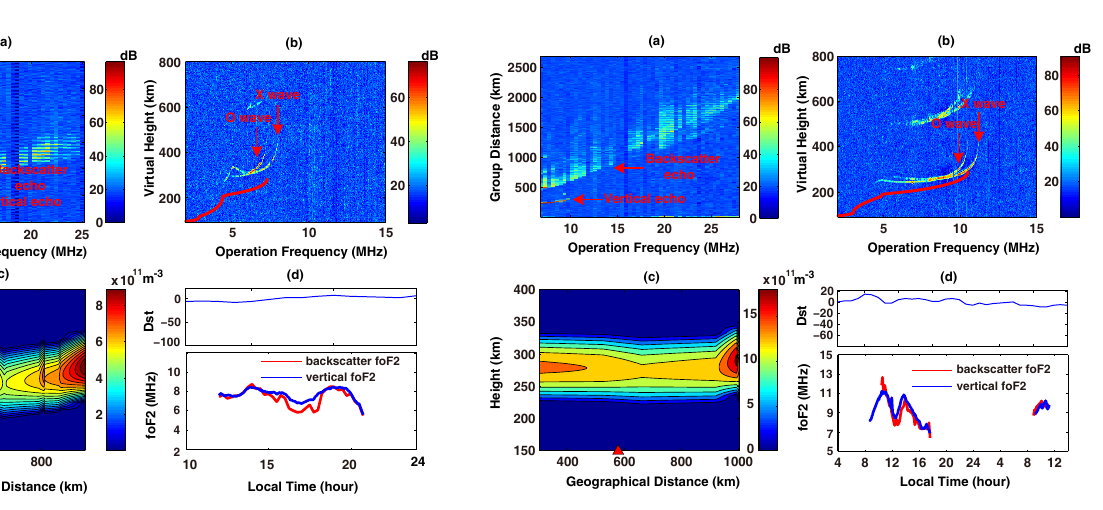
Fig. 5. Same as in Fig. 3, except for the 24 May 2011 experiment illustrated in Fig. 4.